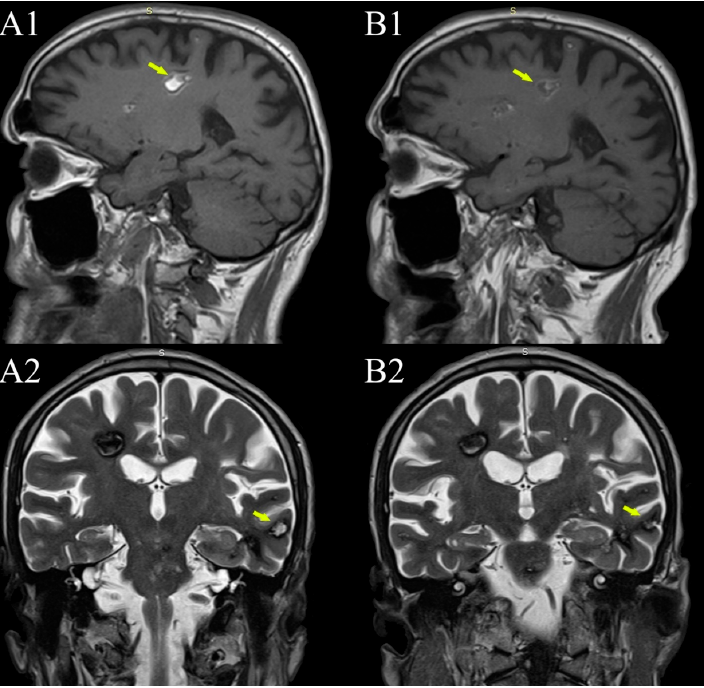
Figure 3. Evolution of in-cavernomas bleeding over time. ( A1 , A2 ) are from the 2015 MRI examination (1.5 T), ( B1 , B2 ) are from the 2021 examination (1.5 T). Coexistence of subacute bleeding in the right parietal lobe white matter cavernoma with T1 hyperintense signal ( A1 —arrow) and T2 inhomogeneous hyper- and hypointense signal and acute bleeding in a smaller left temporal lobe cavernoma with hyperintense T2 signal ( A2 —arrow) (but also hyperintense T1, not shown here). Both lesions became more hypointense in both T1 and T2 on the 2021 MRI examination ( B1 , B2 —arrows).